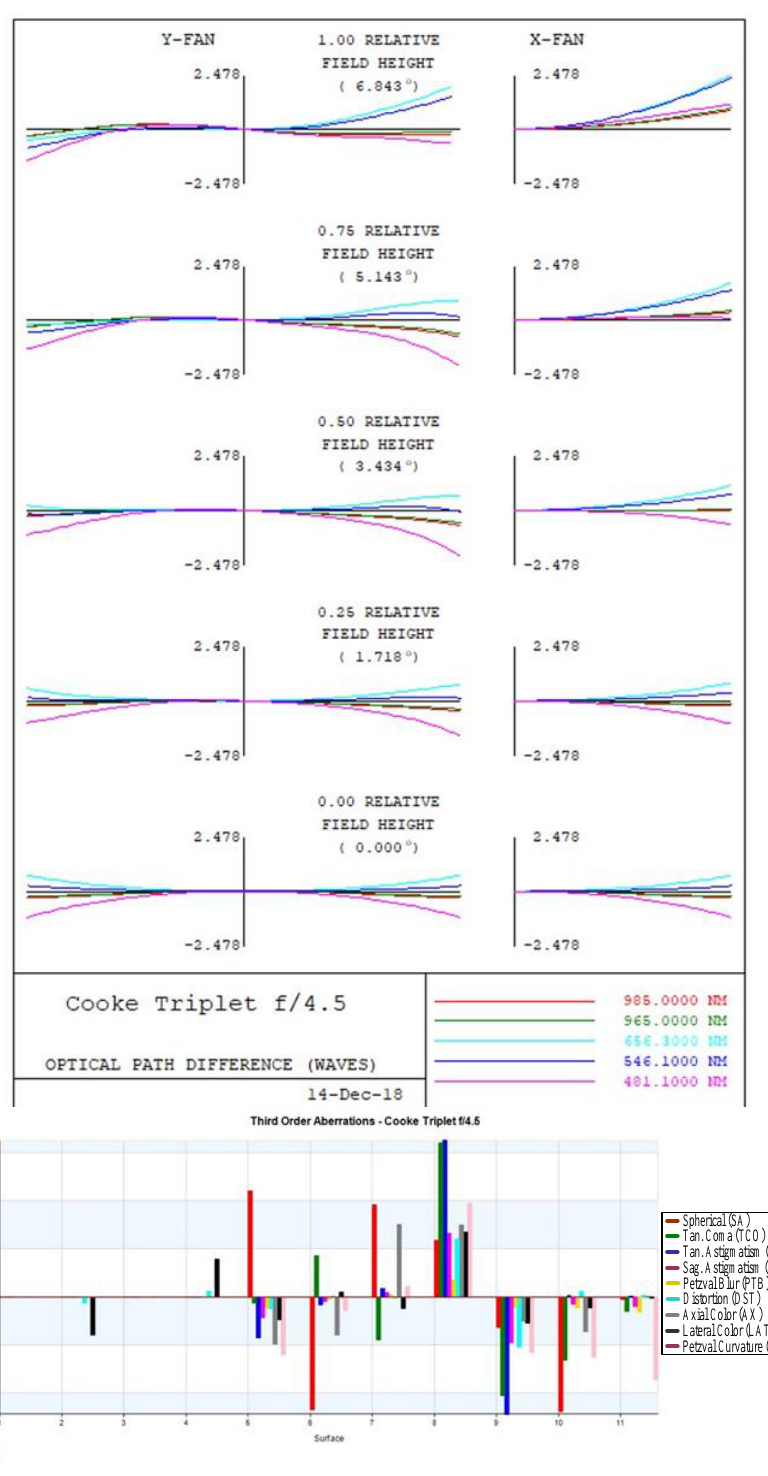
Figure 7. Aberration diagrams of proposed optics.